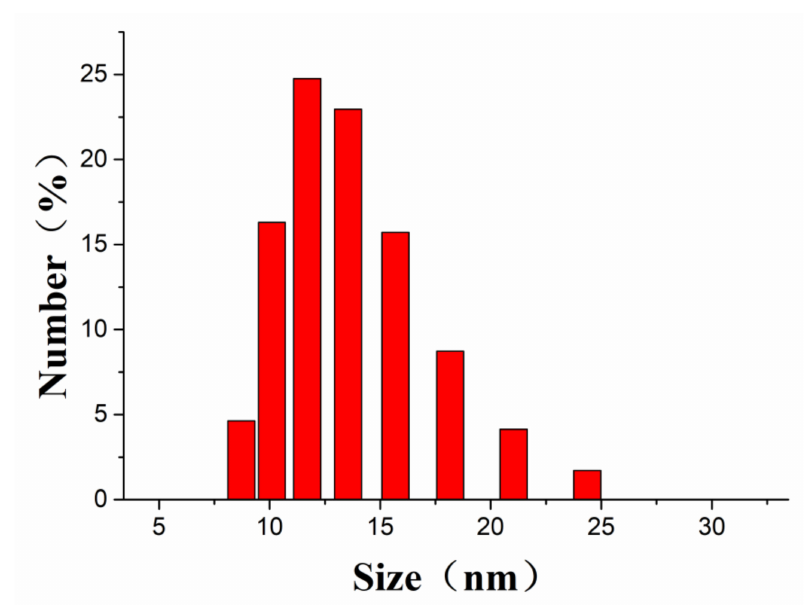
Figure 2. Particle size distribution of CMC-SNs by DLS (dynamic light scattering).